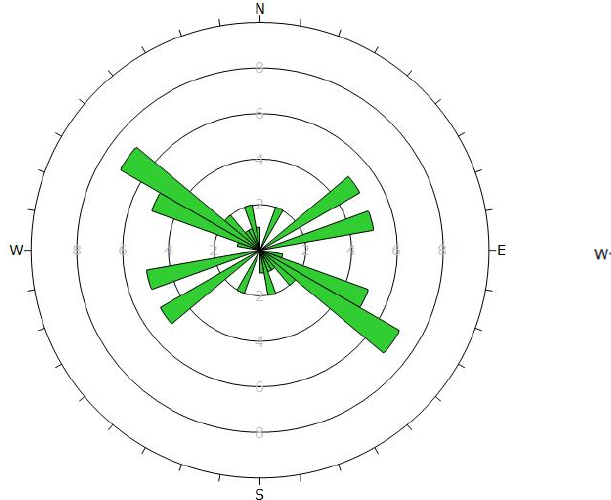
Figure 9. Location of discontinuities data collection points.